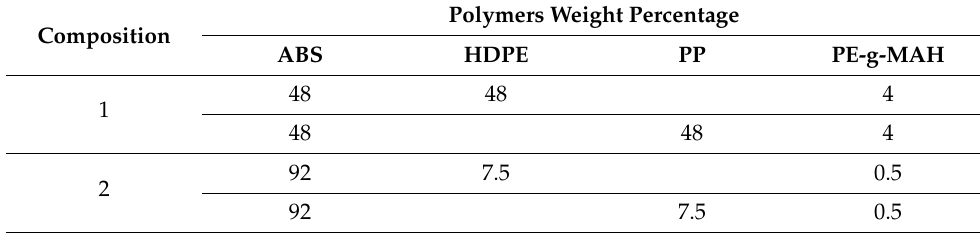
Table 1. Compositions prepared in single screw extruder.